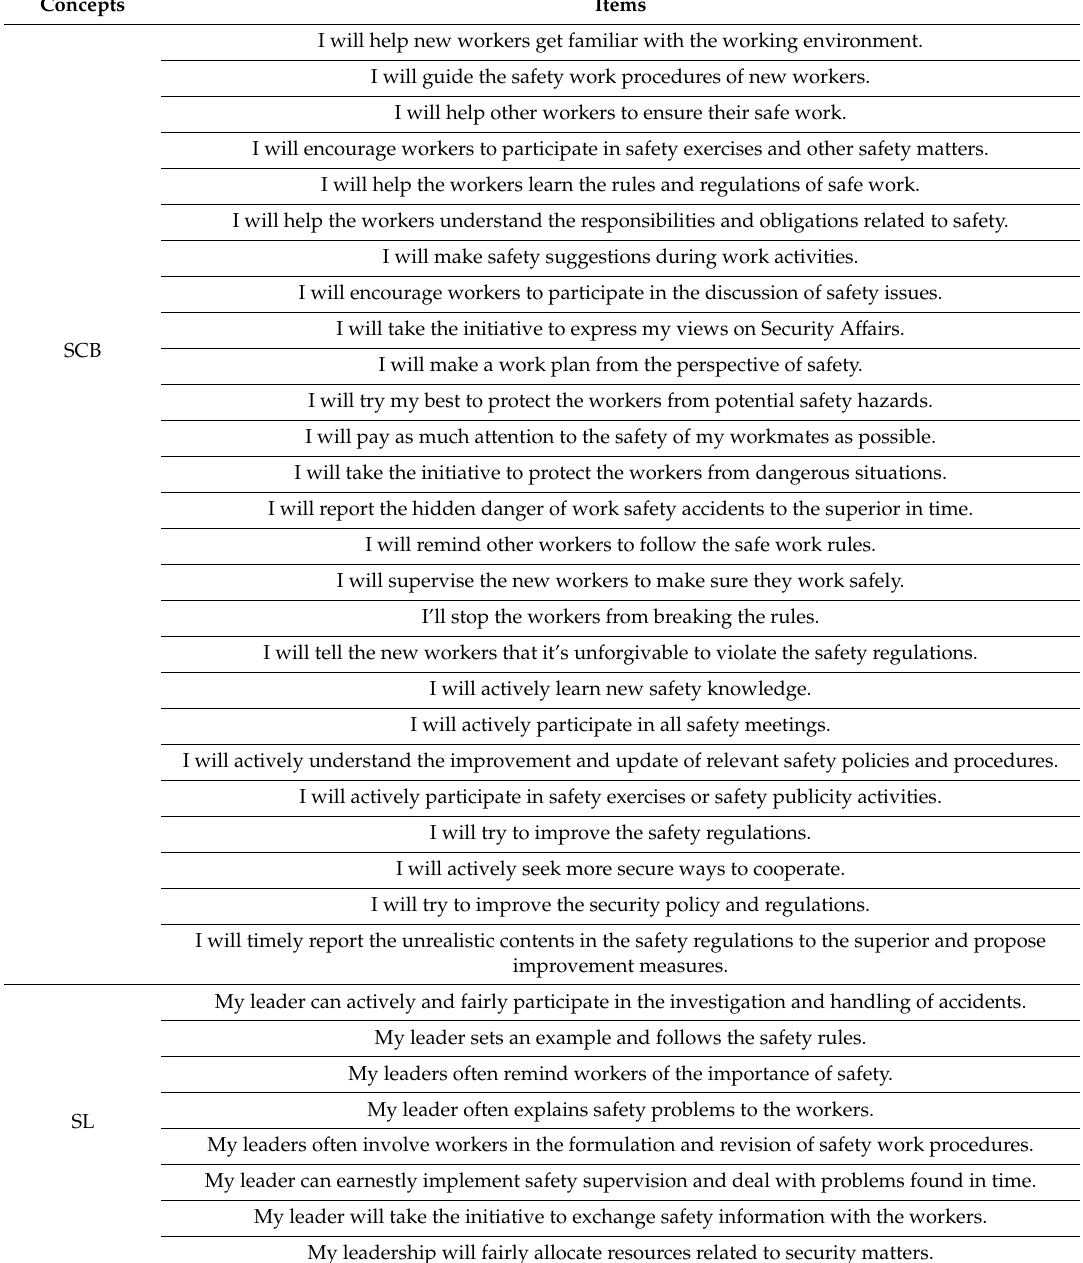
Table A1. Contents of safety citizenship